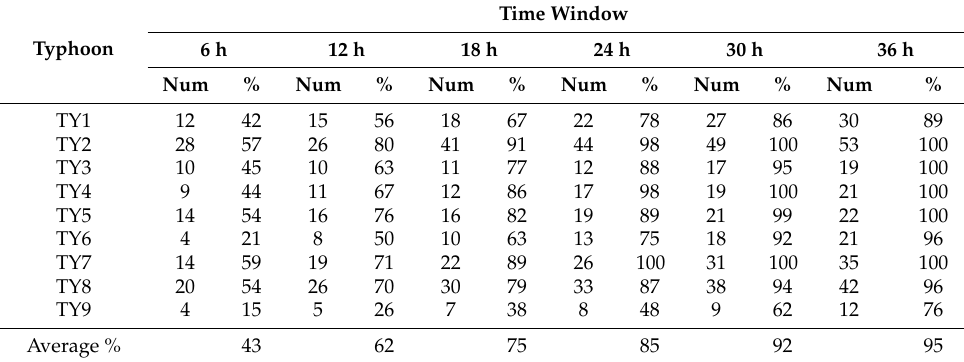
Table 3. Number of COSMIC profiles that were co-located with each of the nine typhoon tracks (in Table 2) in various time windows (“Num” denotes the number of co-located COSMIC profiles; “%” denotes the proportion of typhoon central positions that had at least one co-located RO profile amongst all the typhoons’ central positions).